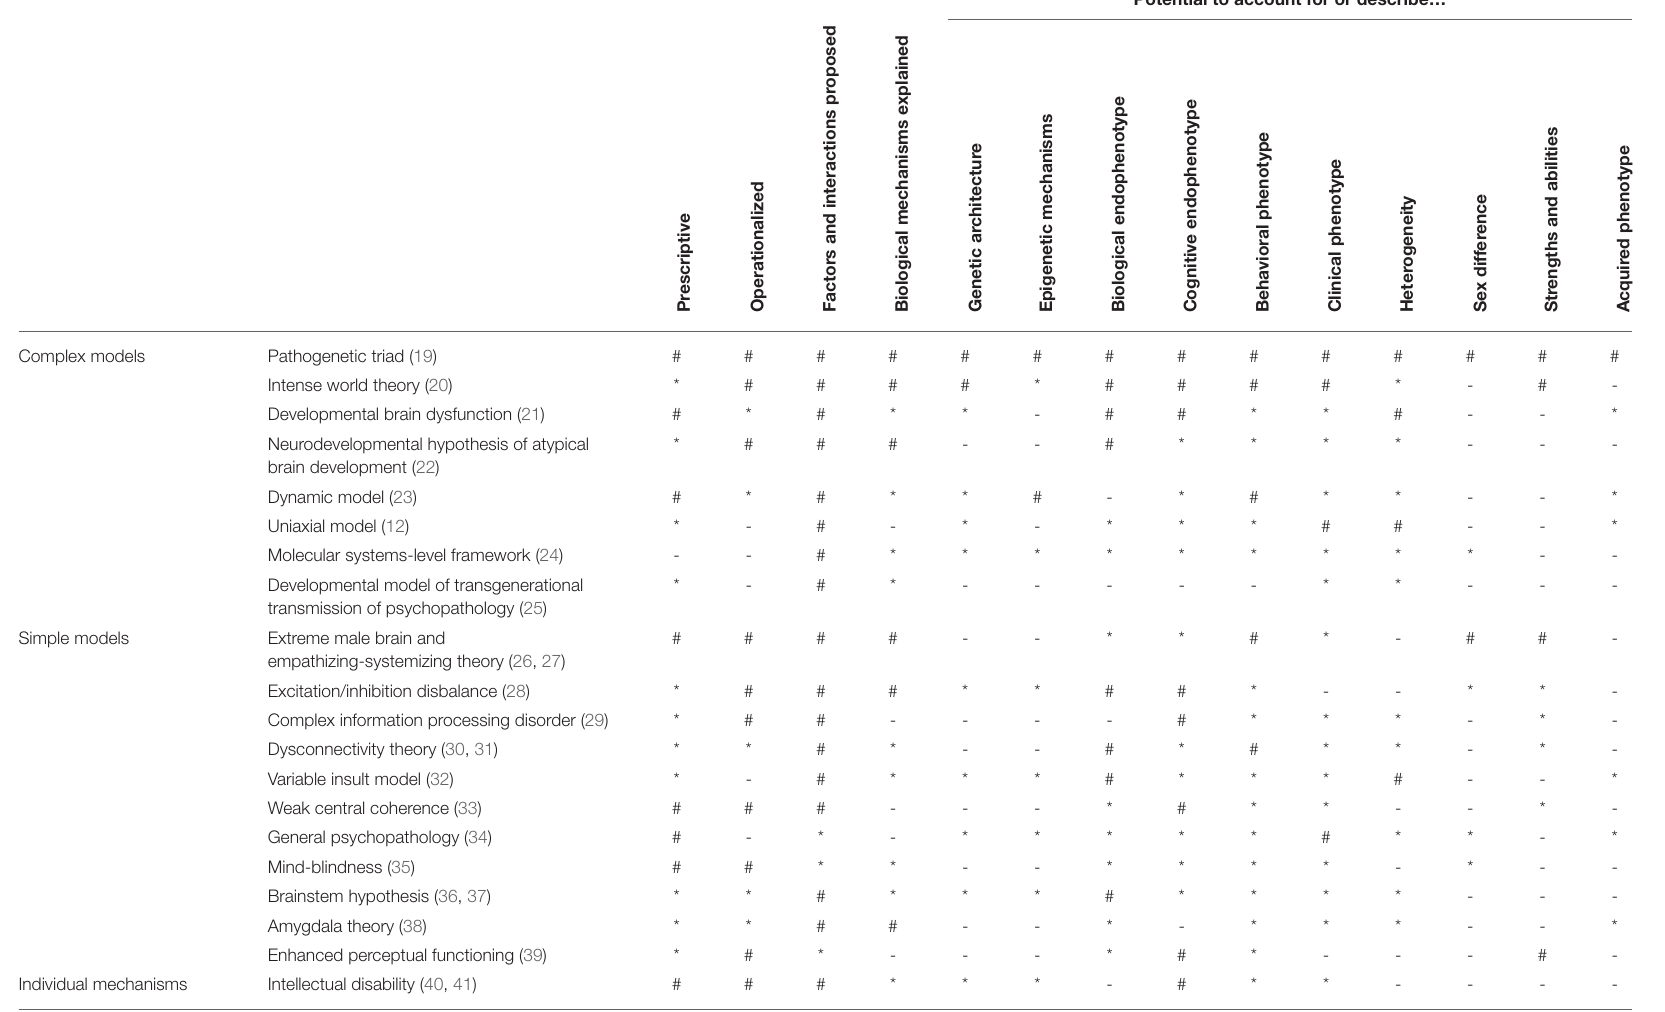
Potential to account for or